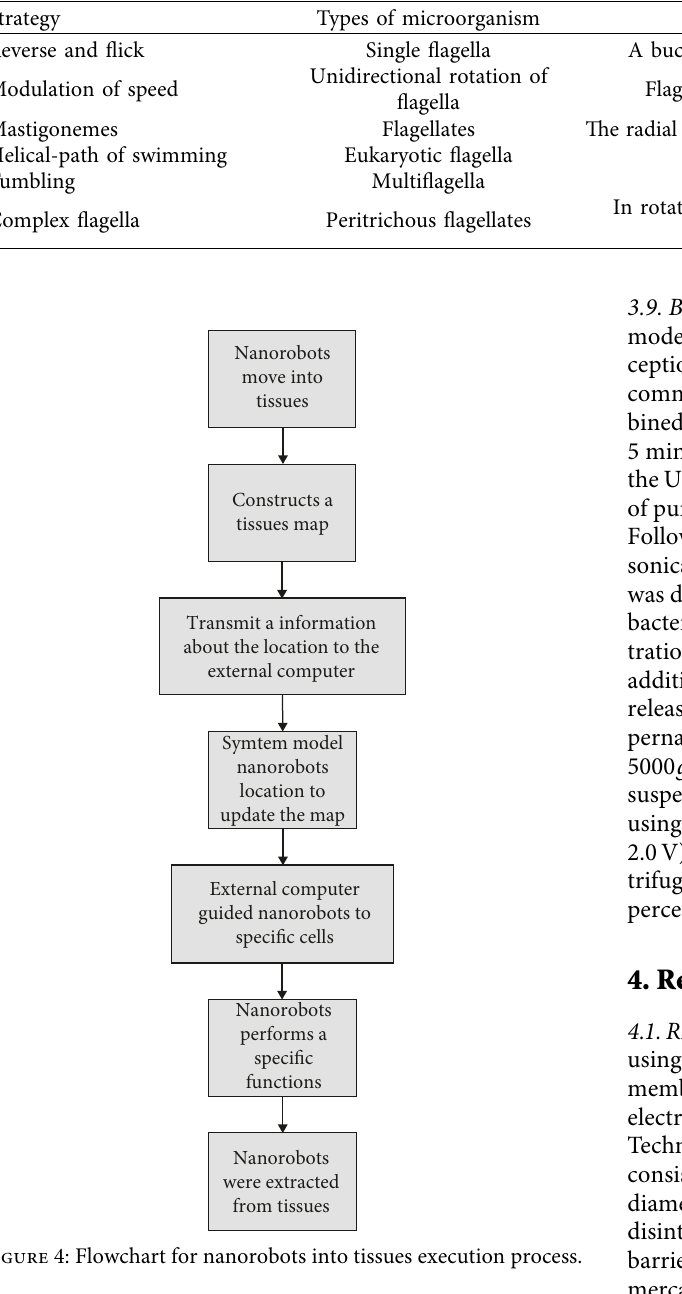
Table 1: Swimming microorganism mechanism and strategy.